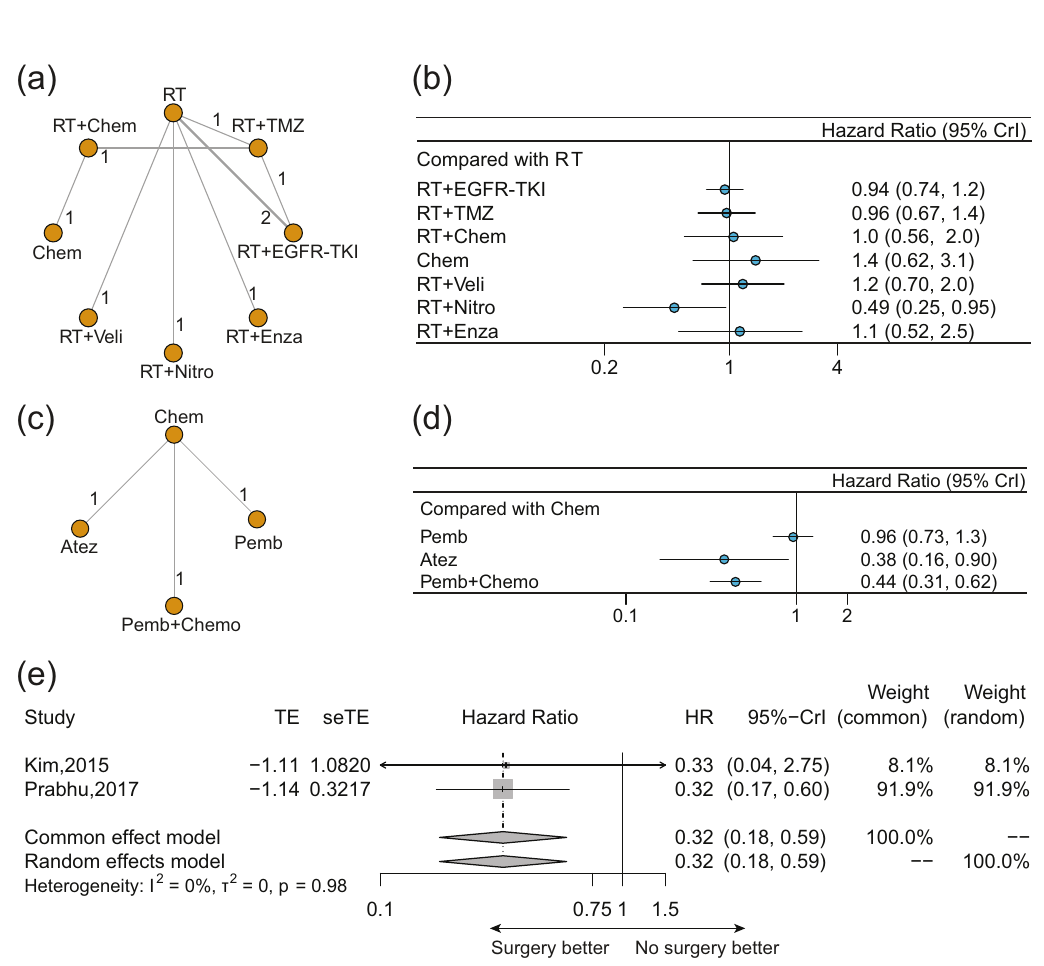
Figure 3: Pooled result of CNS - PFS for di ff erent treatments for BMs from EGFR/ALK - negative/unselected NSCLC. ( a ) Network diagram and ( b ) forest plot of CNS - PFS for di ff erent treatments compared with radiotherapy alone in newly diagnosed BMs. ( c ) Network diagrams and ( d ) forest plot of CNS - PFS for di ff erent treatments compared with chemotherapy alone in previously treated BMs. ( e ) Forest plot of CNS - PFS comparing surgery with radiotherapy alone. Each node in the network diagram represents one treatment, and the numbers represent direct head - to - head comparisons. Abbreviations: RT, radiotherapy; TMZ, temozolomide; EGFR - TKI, epidermal growth factor receptor - tyrosine kinase inhibitors; Enza, enzastaurin; Nitro, nitroglycerin; Veli, veliparib; Chem, chemotherapy; Pemb, pembrolizumab; and Atez,